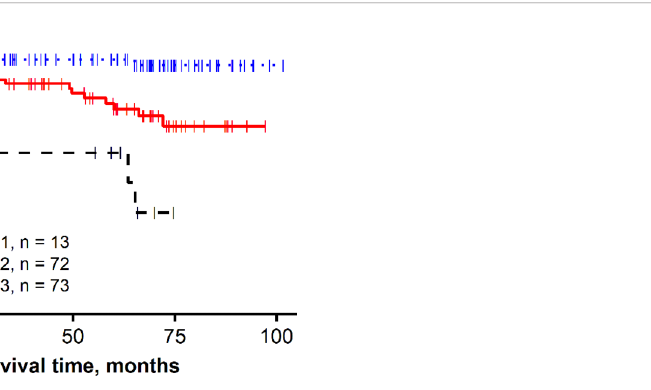
FIGURE 3 | Kaplan – Meier plot for the overall survival of prognostic groups obtained by combined CD8 Immunogradient prognostic score (CD8_IPS) in HER2 non- ampli fi ed